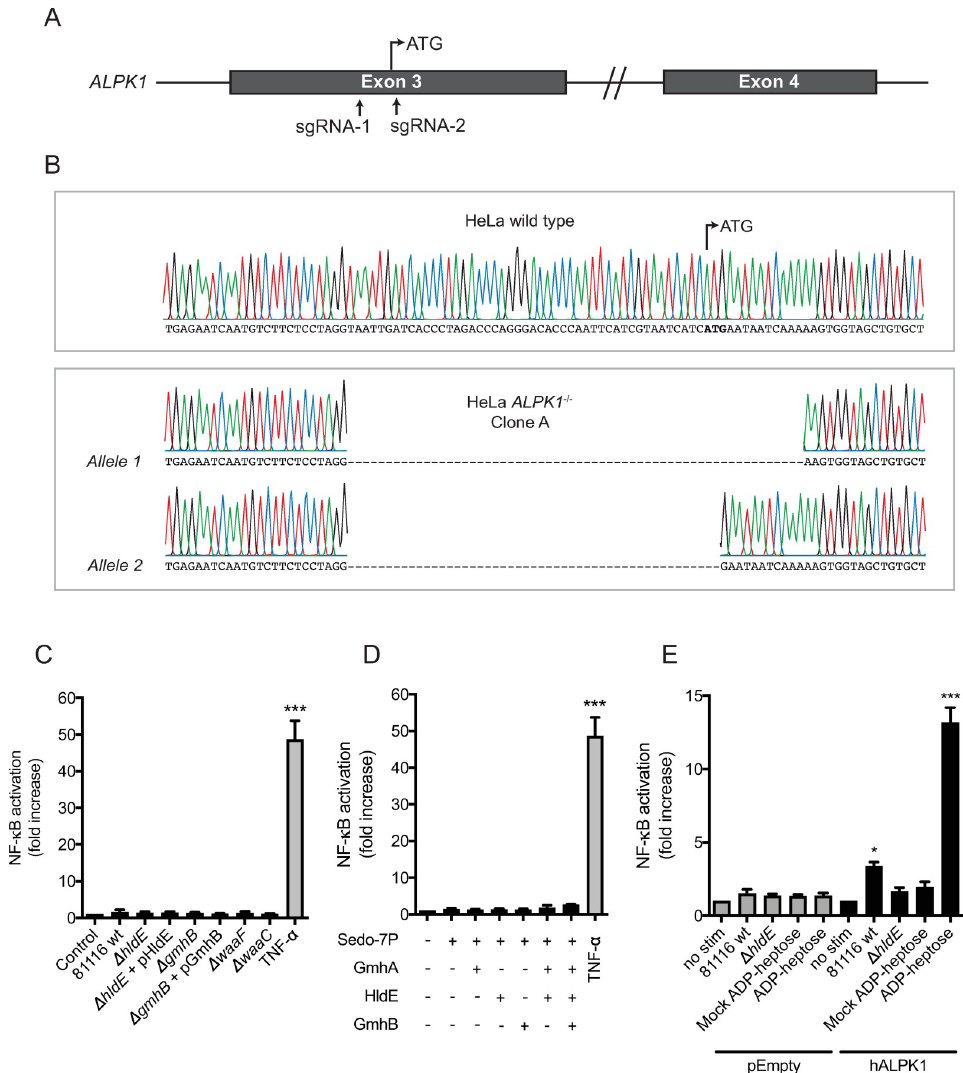
Fig 5. C . jejuni -derived ADP-heptose and/or heptose metabolites-mediated NF- κ B activation is dependent on ALPK1. (A) Schematic overview of the CRISPR/Cas9 deletion strategy, showing the locations of the two sgRNAs targeting the ALPK1 exon 3. (B) Sequence analysis of the ALPK1 exon 3 from wild type HeLa 57A cells and to HeLa 57A ALPK1 -/- Clone A. HeLa 57A cells deficient in ALPK1 (HeLa 57A ALPK1 -/- , Clone A) were stimulated for 5 h with (C) sterile conditioned culture medium of wild type C . jejuni 81116 or the indicated (complemented) mutant strains, or (D) with the endproduct of various heptose synthesis reactions. As a positive control, TNF α was included. (C) HeLa 57A ALPK1 -/- cells (Clone A) were transfected with an empty expression plasmid or transfected with a plasmid expressing human ALPK1 , and subsequently stimulated for 5 h with sterile conditioned culture medium of wild type C . jejuni 81116, C . jejuni 81116 Δ hldE , mock ADP-heptose of ADP-heptose derived from in vitro synthesis using C . jejuni enzymes. NF- κ B activation was measured as relative luciferase units and presented as fold increase in stimulated versus unstimulated cells. Results are the mean ± SEM of three independent experiments performed in duplicate. � p < 0.05, �� p < 0.01, and ��� p < 0.001.